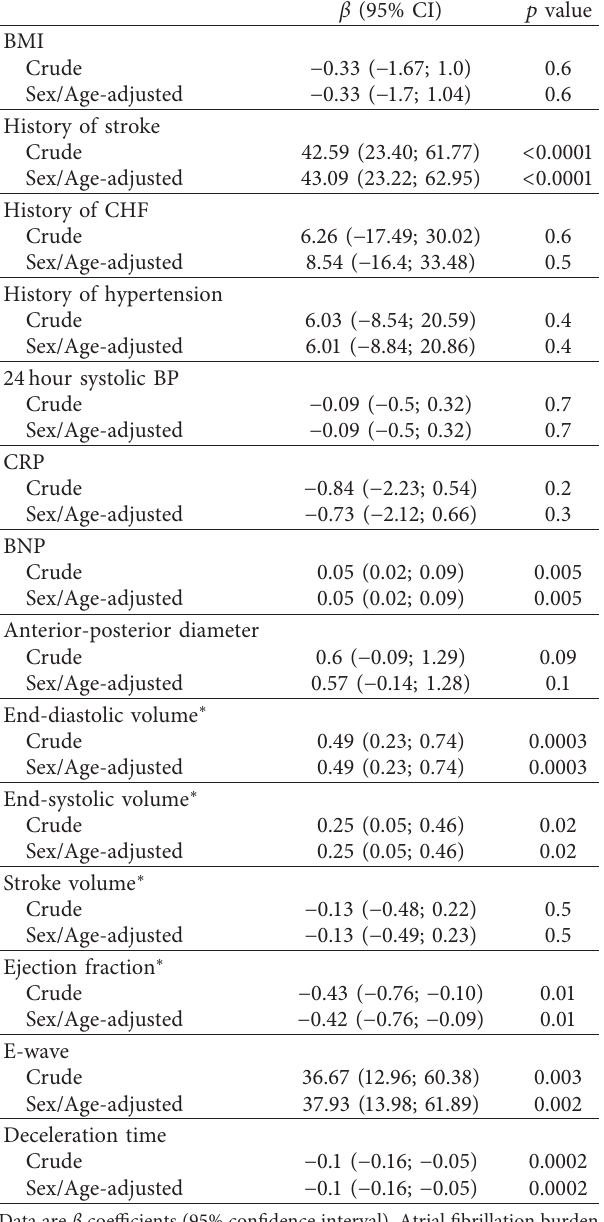
Table 2: Separate, mixed effect models for the relationships of atrial fibrillation burden and clinical, laboratory, and left atrial echo- cardiographic parameters.